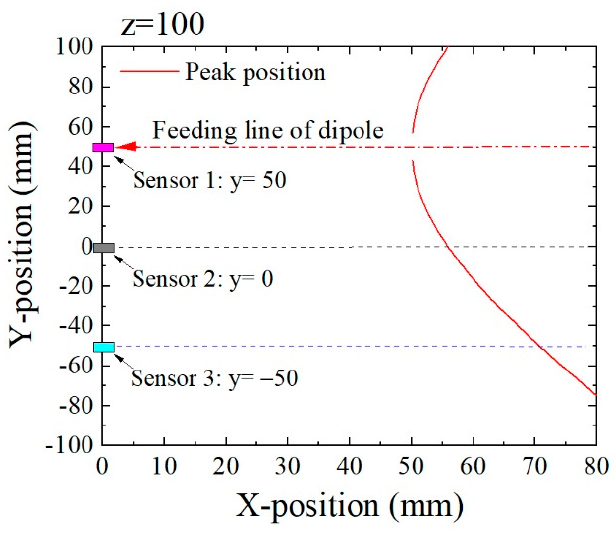
Figure 7. Variation of the extreme point’s position when a magnetic dipole was fed on y = 50, z = 50.